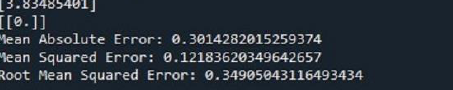
Fig 5. Linear regression accuracy metrics .